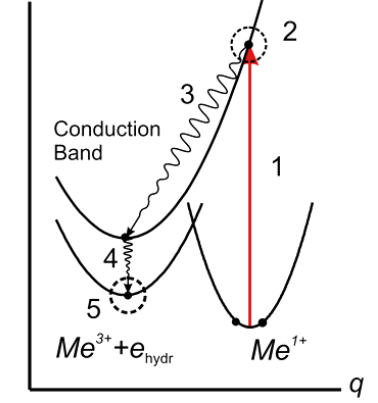
Figure 3. Generalized diagram of configuration coordinates for the states of bistable center in CdF crystal. Schematic representation of processes 1–5 at deep-to-shallow center 2 transformation are shown (see below in the text). Lattice relaxations that correspond to other configuration coordinates than q, are indicated by dotted circles. Non-radiation transitions with photon emission are shown by wavy lines.